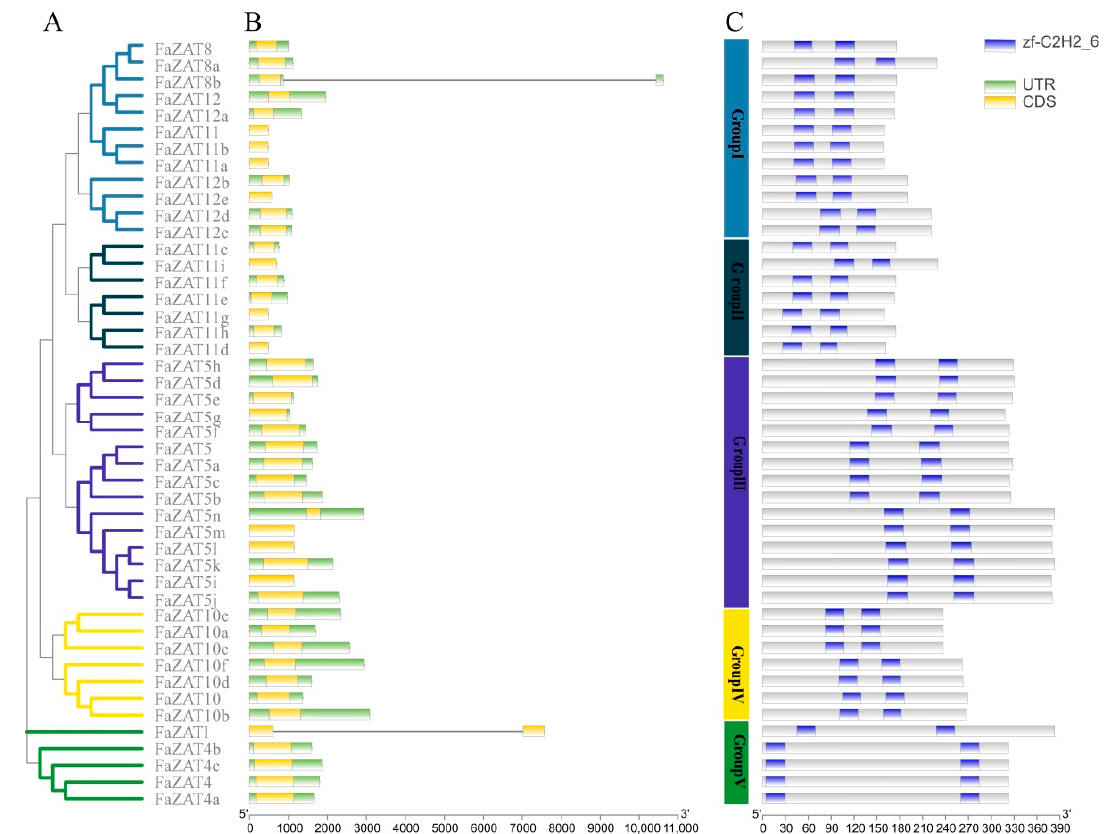
Figure 3. The evolutionary tree ( A ), gene structures ( B ), conserved domains ( C ), and conserved motifs of the cultivated strawberry C1-2i subclass. Blue rectangles are conserved C2H2 domains, yellow rectangles are UTRs, and green rectangles are CDS. The phylogenetic tree was developed on MEGA (version 7.0) using the neighborhood-joining phylogenetic method analysis. Both the bootstrap test and the approximate likelihood ratio test were set to 1000 times.